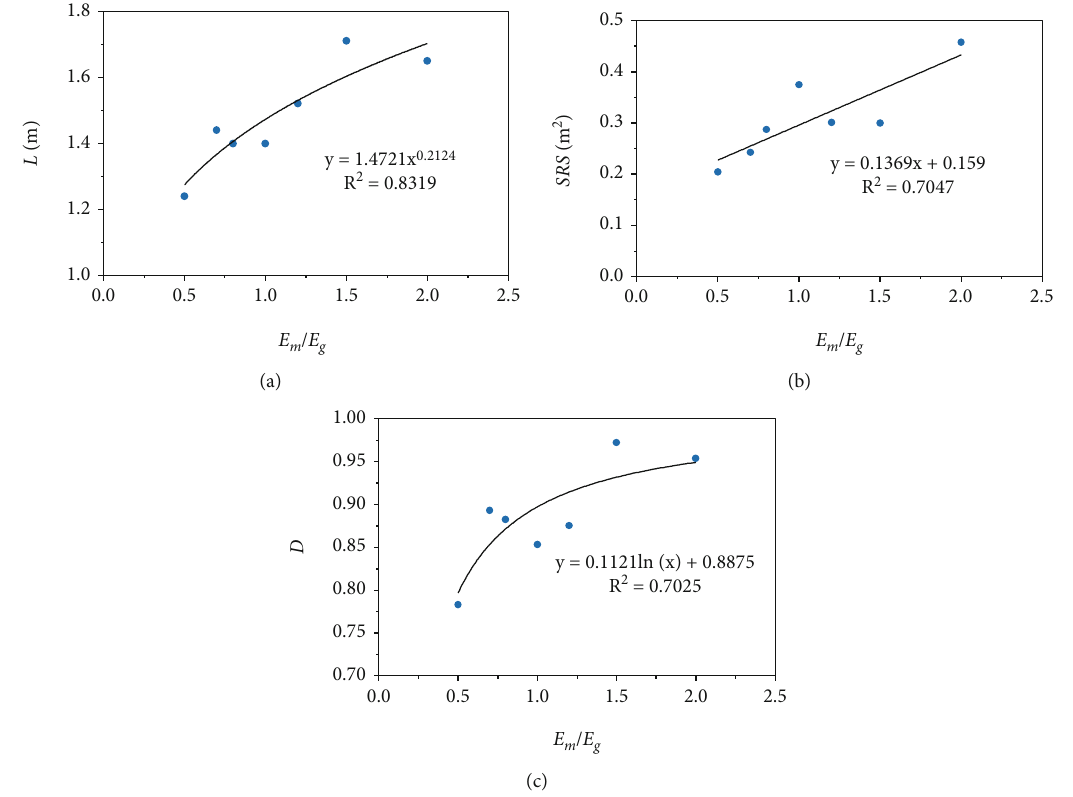
Figure 10: Geometric parameters of HF under di ff erent ratios of the elastic modulus of the matrix to